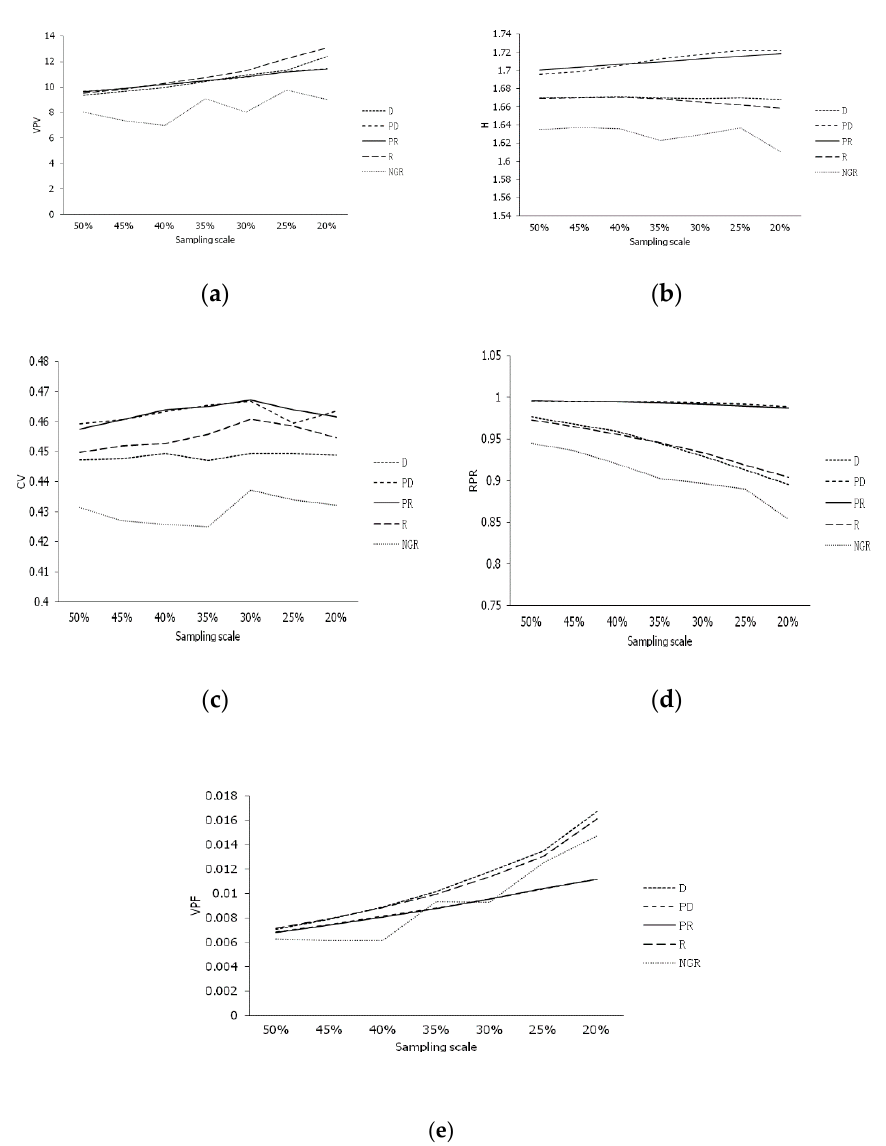
Figure 2. Tendency of parameters for sampling methods in different sampling scales. ( a ) Tendency of VPV ; ( b ) Tendency of H ; ( c ) Tendency of CV ; ( d ) Tendency of RPR ; ( e ) Tendency of VPF . H : Shannon–Weaver diversity index, CV : coefficient of variation, VPV : variance of phenotypic value, VPF : variance of phenotypic frequency, RPR : ratio of phenotype retained. D, PD, PR, R, and NGR stand for deviation sampling (D), prior and deviation sampling (PD), prior sampling (PR), random clustering (R), and non-group random sampling method (NGR),